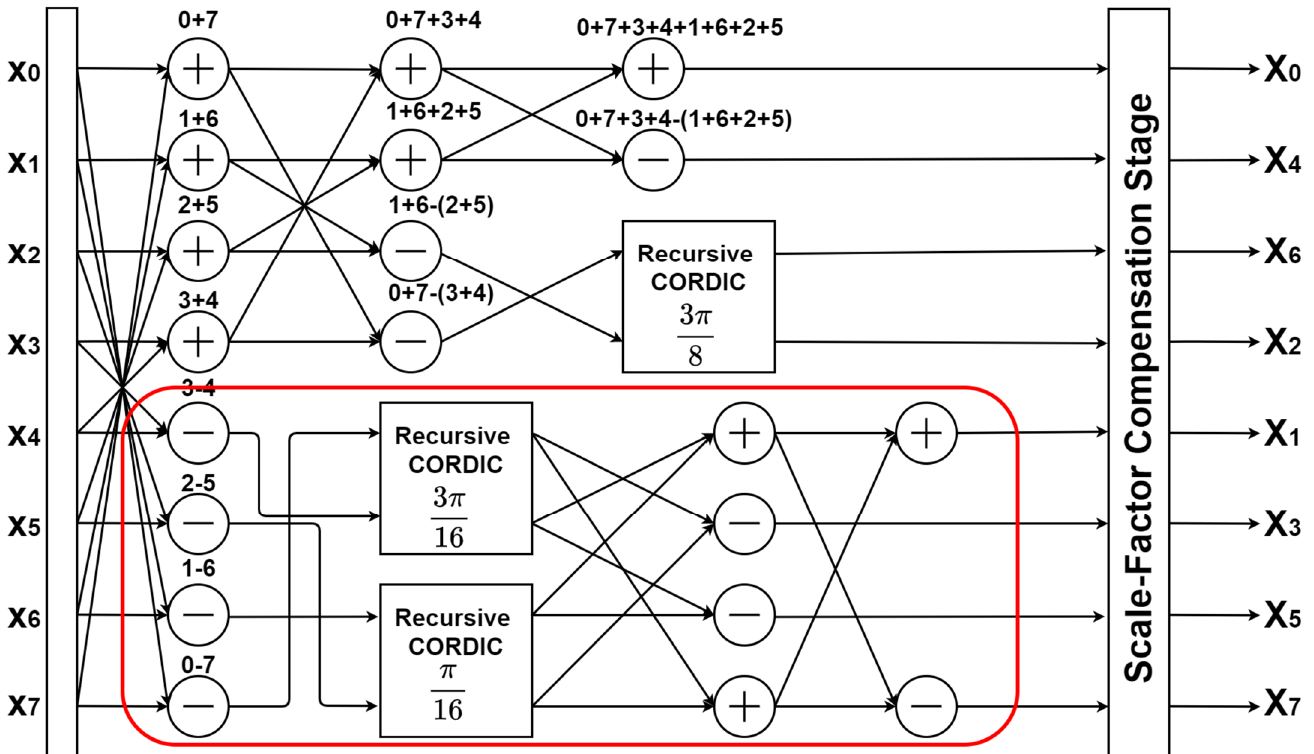
Figure 4. Flow graph of the Loeffler DCT with recursive coordinate rotation digital computer (CORDIC).